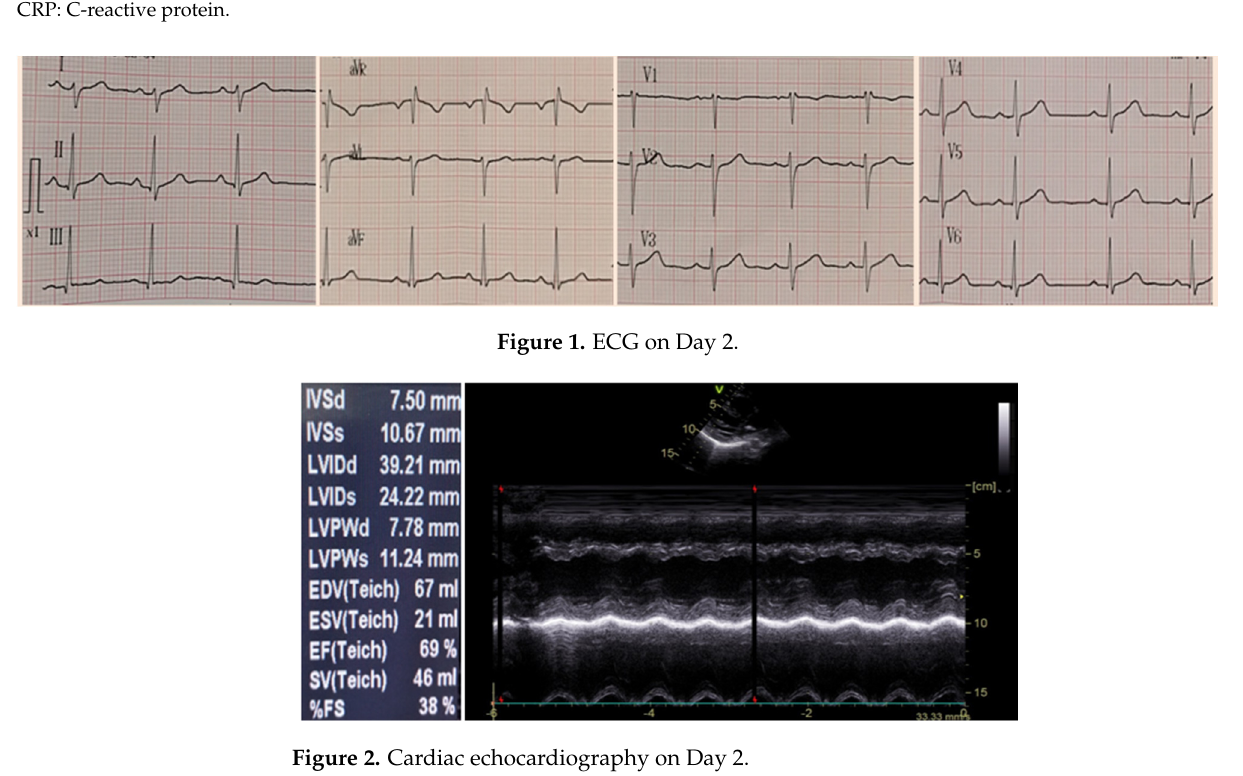
Table 2. Microbiological tests.